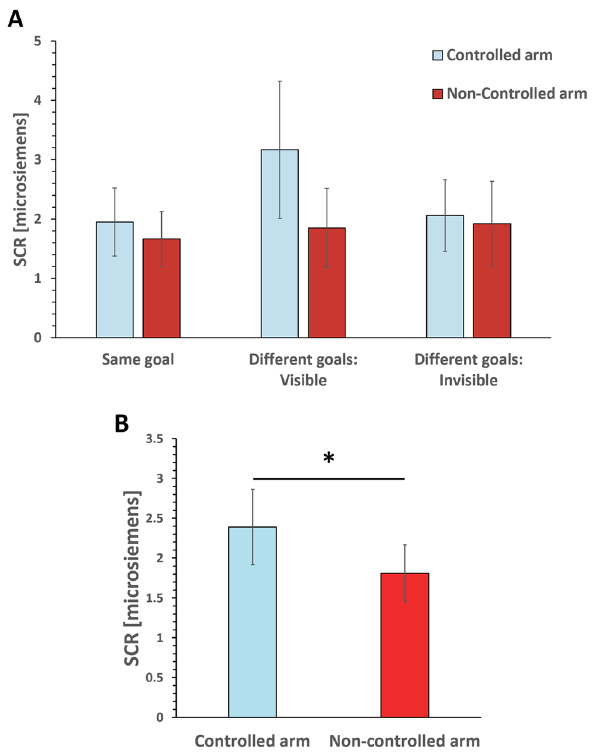
Figure 6. Skin conductance response. ( A ) Skin conductance response when the knife stabbed controlled or non-controlled arm at the end of each condition. ( B ) The three goal conditions were merged because neither the main effect of goal condition nor the interaction was significant. The skin conductance response was higher when the knife stabbed the controlled arm compared to when it stabbed the non-controlled